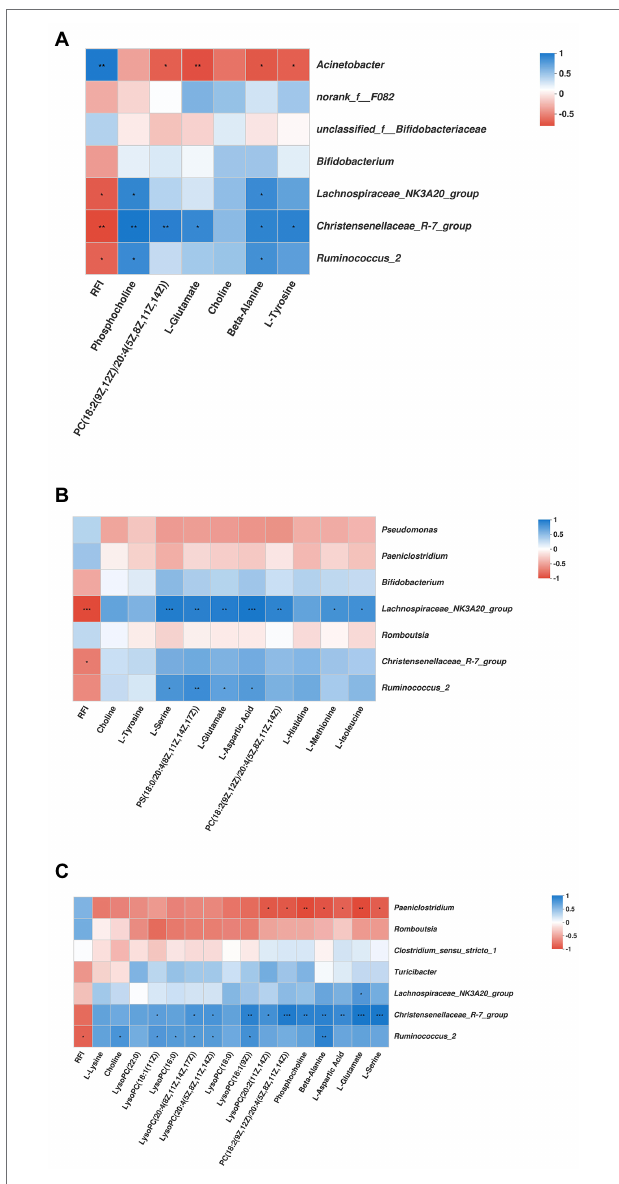
FIGURE 9 | Correlation analysis among the predominant genera duodenum (A) , jejunum (B) , ileum (C) microbiota bacteria, the significantly differential metabolites, and the RFI. Cells are colored based on Spearman’s correlation coefficient: blue represents a positive correlation; red represents a negative correlation. *Represents 0.01 < p ≤ 0.05; ** represents 0.001 < p ≤ 0.01; and *** represents p ≤